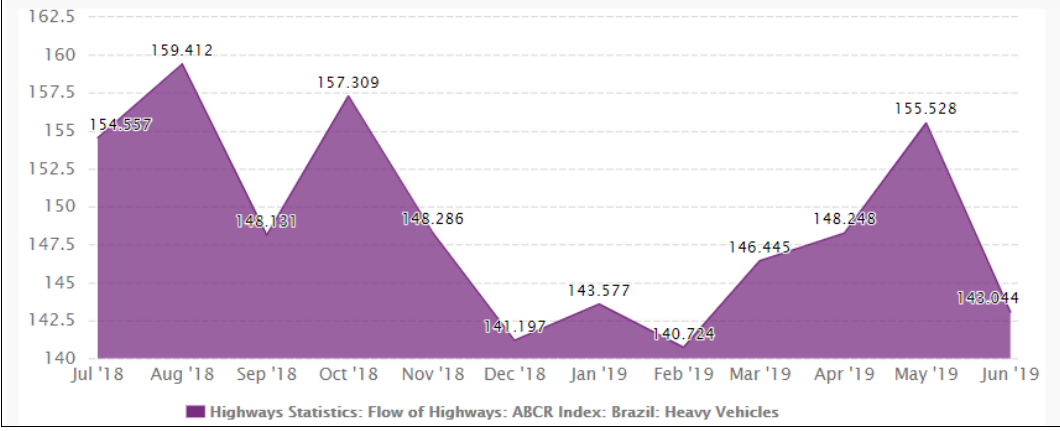
Figure 2. Brazil ’ s flow of highways considering only heavy vehicles from Jan 1999 to Jun 2019 (CEICDATA,